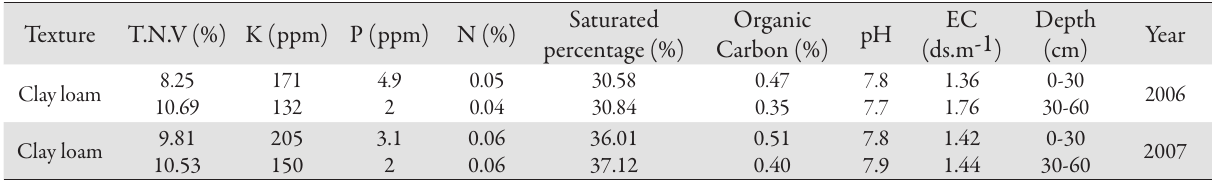
Tab. 1. Physical and chemical properties of soil collected from site study